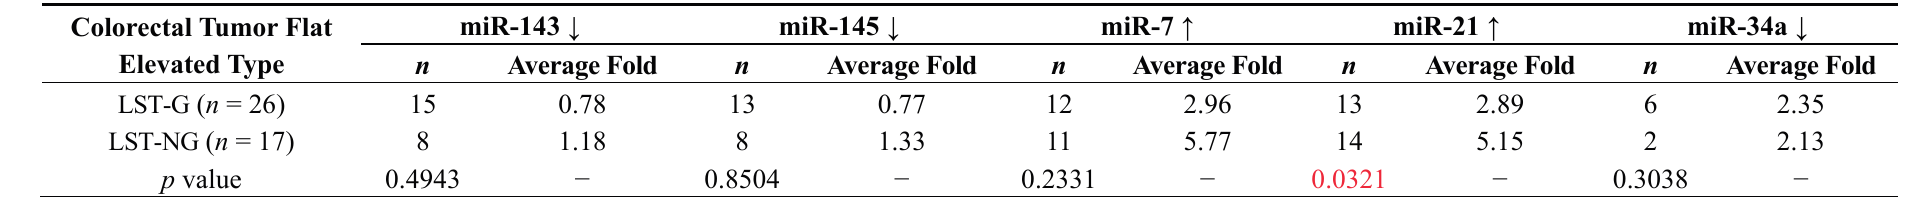
Table 5. Expression of miR-143, -145, -7, -34a, and -21 in human colorectal adenoma and early cancer tissues (laterally spreading tumor (LST): granular type (LST-G) and non-granular type (LST-NG)). Colorectal Tumor